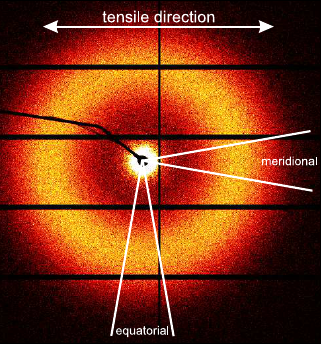
Figure 6. Regions used for radial integration of the SAXS